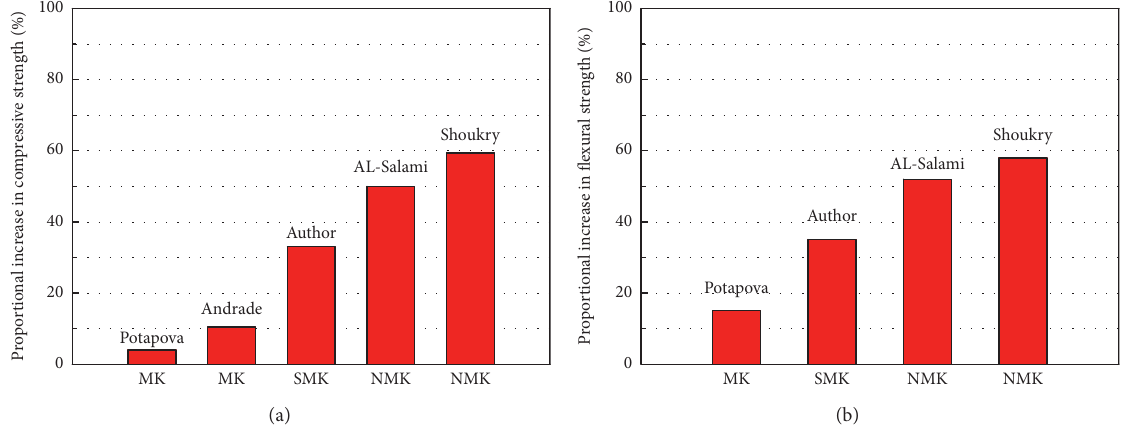
Figure 9: The proportional increase in (a) the compressive strength and (b) the flexural strength of the SMK compared to the data in the literature.